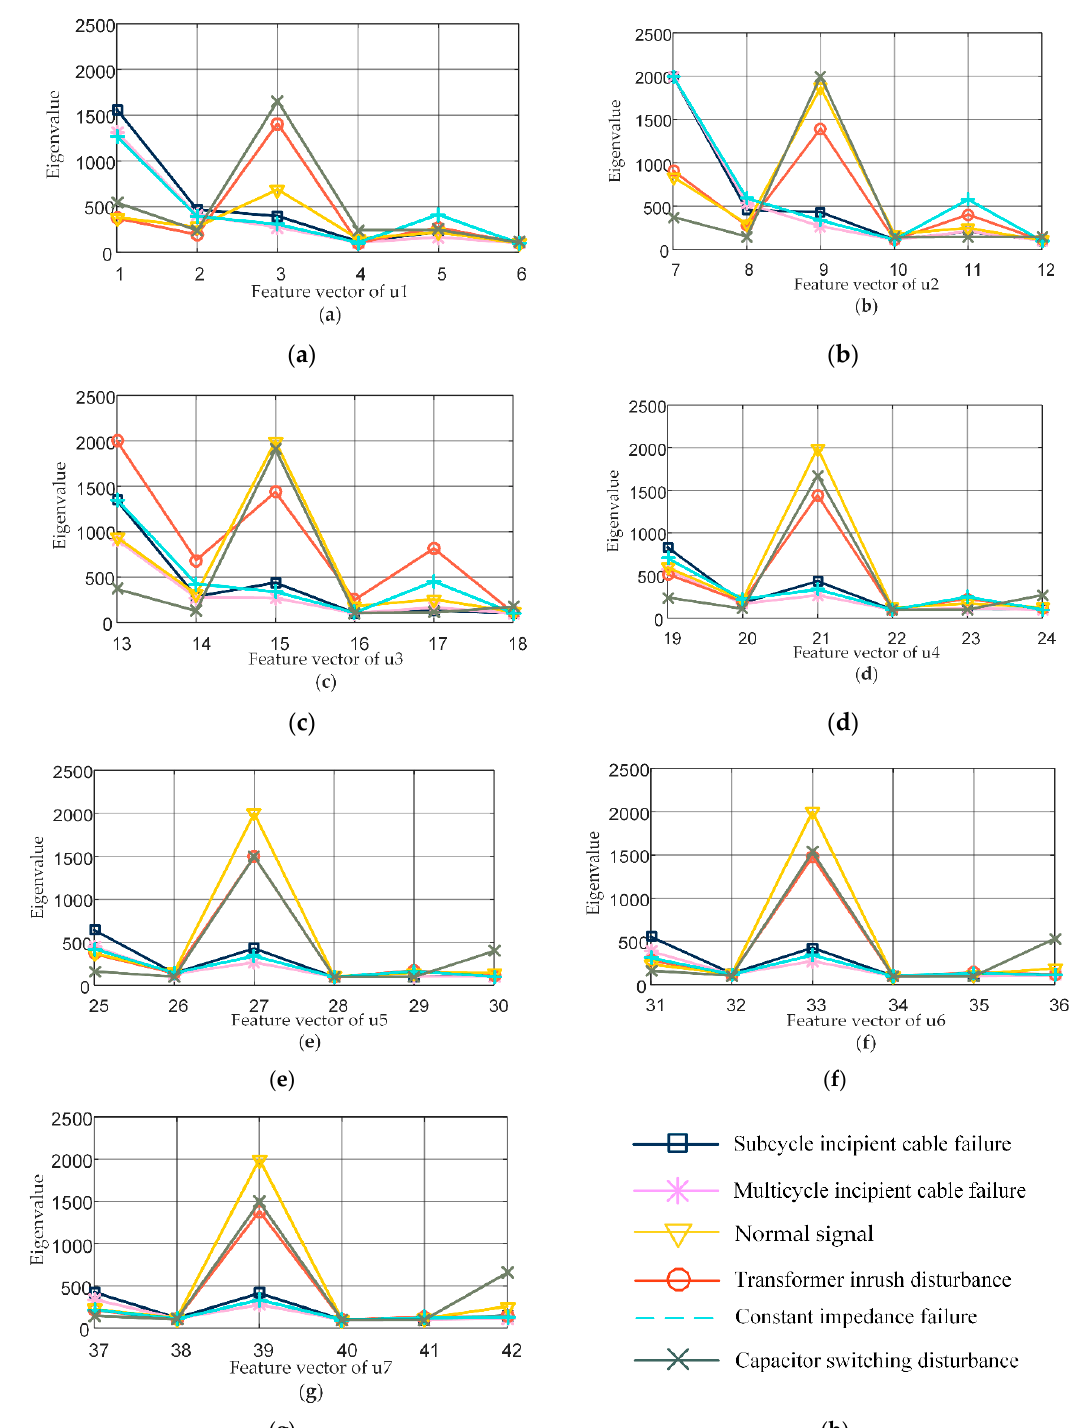
Figure 8. Feature extraction based on VMD: ( a )–( g ) denotes the respective feature vector FV k of the u1–u7 decomposed modes. ( h ) denotes the representation of different signal types.